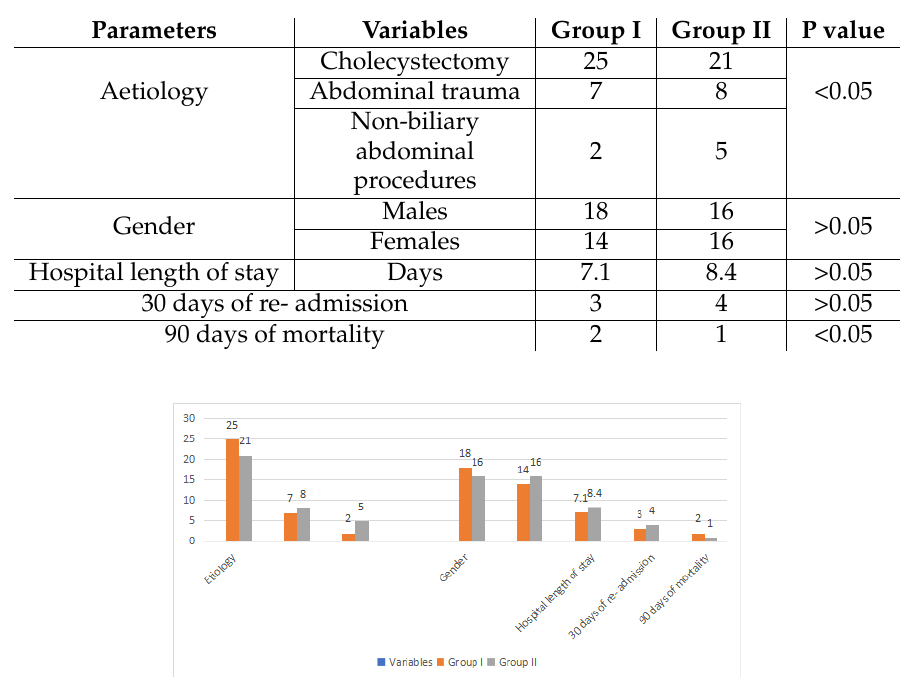
Table 1. Comparison of parameters